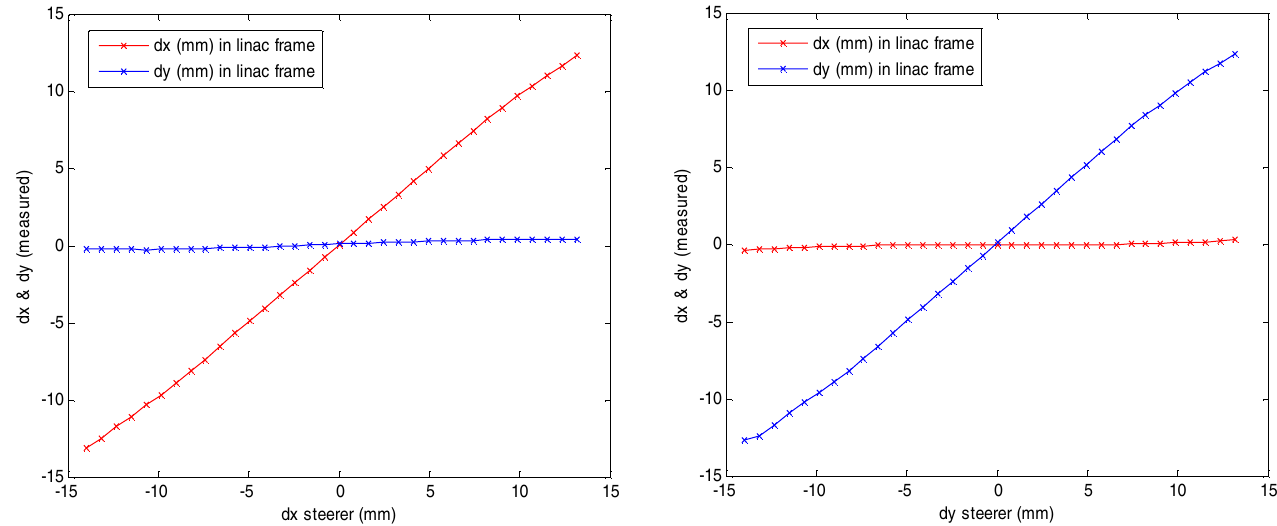
FIG. 19. (Color) Position read by the reentrant BPM vs the predicted position from horizontal (left) and vertical (right) steerings with 1 nC